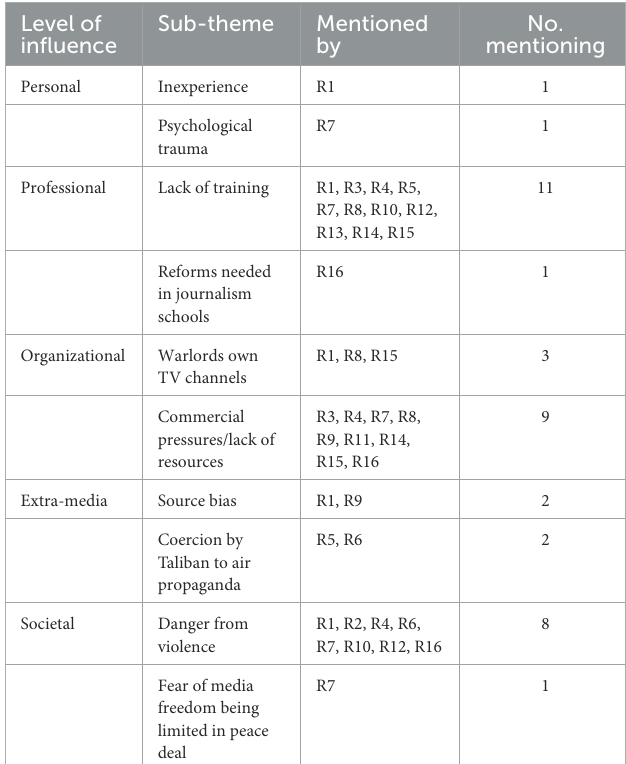
TABLE 5 Influences on news